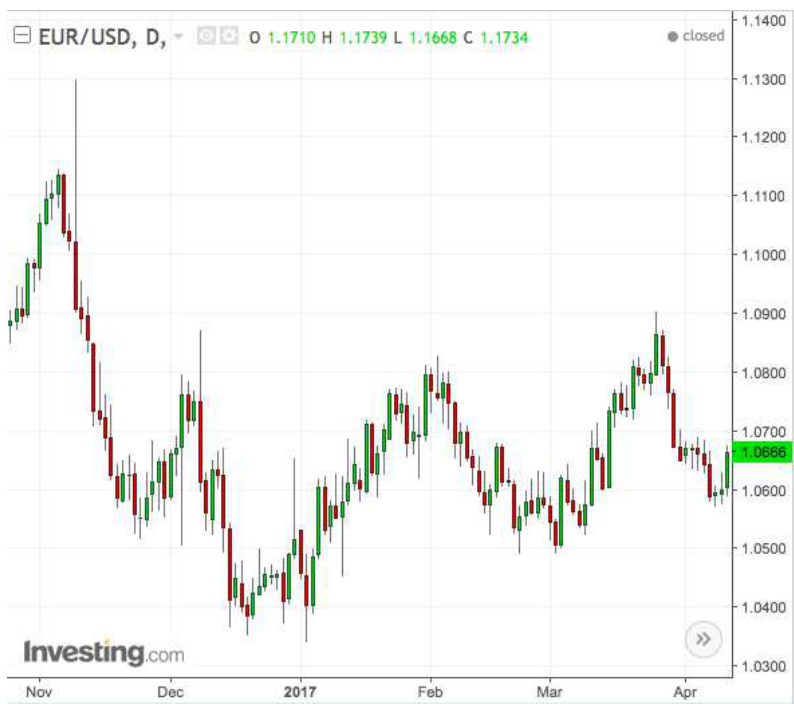
Figure 6. Dynamics of the EUR/USD pair from November 2016 to April